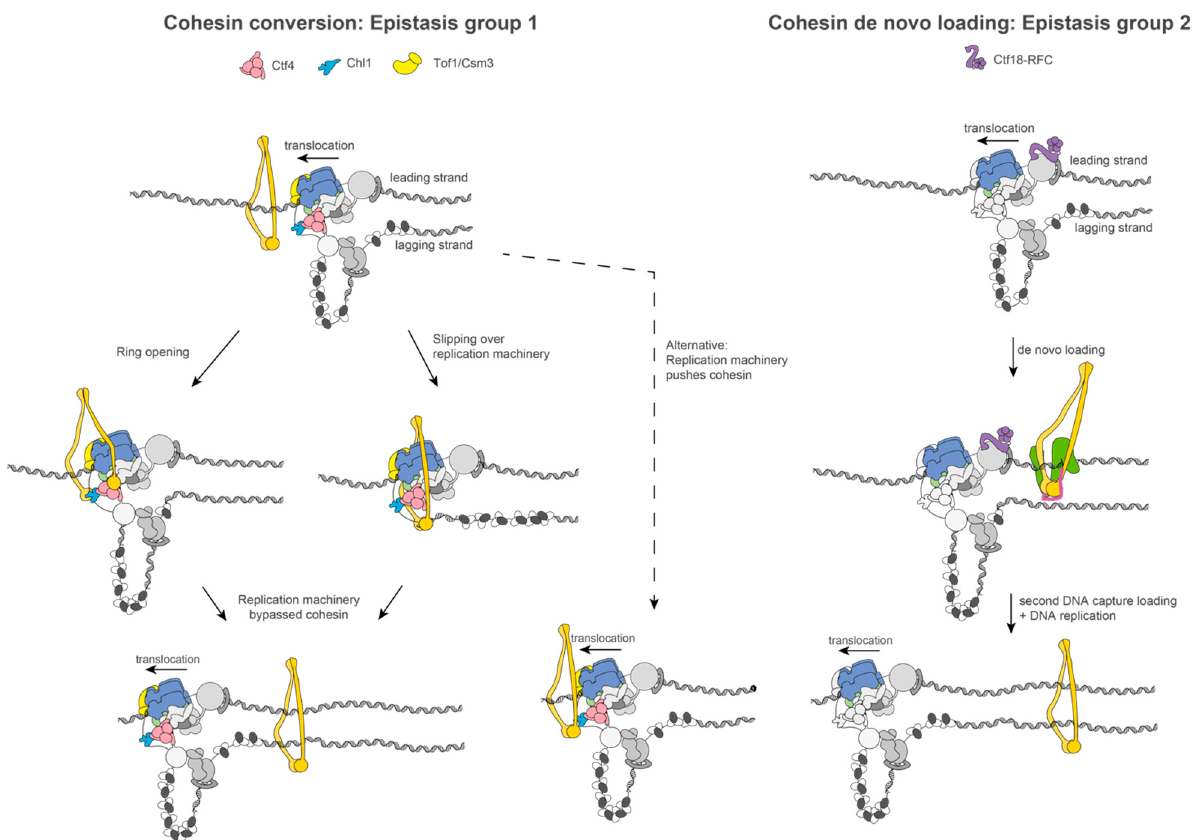
Figure 3. Two pathways for cohesion establishment: cohesin conversion and cohesin de novo loading. Cohesin loaded on parental duplex DNA transitions to two duplicated DNA molecules. According to the cohesin conversion model, this transition may involve the Smc ring opening or the cohesin ring slipping over the replicative machinery. This cohesin conversion pathway has been described to utilise the Ctf4 adapter protein (pink), Chl1 helicase (light blue), and Tof1/Csm3 fork protection factor (yellow). Alternatively, cohesin may be pushed by the replication machinery towards sites of replication termination. The second pathway, namely, cohesin de novo loading, depicts new cohesin molecules to be loaded behind the replicative machinery using nucleoplasmic cohesin molecules, which may originate from the cohesin dissociation of parental duplex DNA. This pathway utilises Ctf18–RFC (purple), which is located towards the rear of the replication machinery.